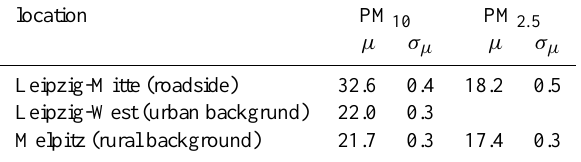
Table 2. Number of exceedances per year of the daily limit value for PM 10 . The number of valid measurement days is added in brack-